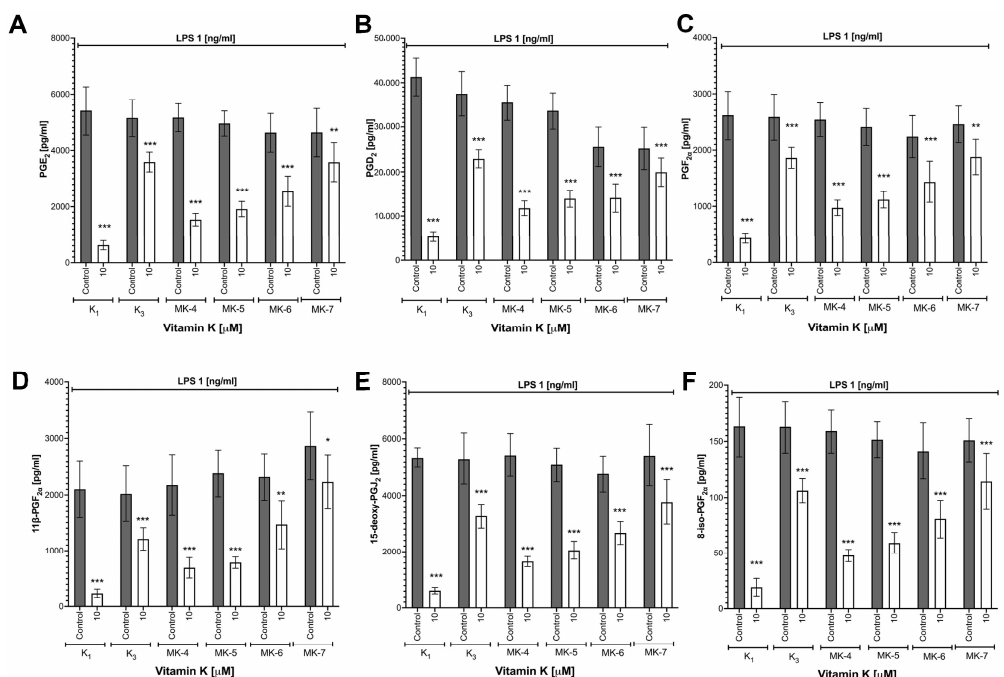
Figure 2 Figure 2. The inhibition of eicosanoid production by various forms of vitamins K in RAW 264.7 cells stimulated with LPS. PGE 2 ( A ), PGD 2 ( B ), PGF 2 α ( C ), 11 β -PGF 2 α ( D ), 15-deoxy-PGJ 2 ( E ) and 8-iso-PGF 2 α ( F ) were measured in medium using the UHPLC-MS/MS technique in post-culture after 48 h incubation with various forms of 10 µ M vitamins K in the presence of 1 ng/mL LPS (24 h). Data are shown as means ± SD from three independent experiments and technical replicates without outliers ( n = 8–9). Statistical significance was evaluated by two-way ANOVA followed by Sidak’s post hoc multiple comparisons using GraphPad Prism 9 software. The symbols *, ** and *** indicate statistical significance at p < 0.05, 0.01 and 0.001,